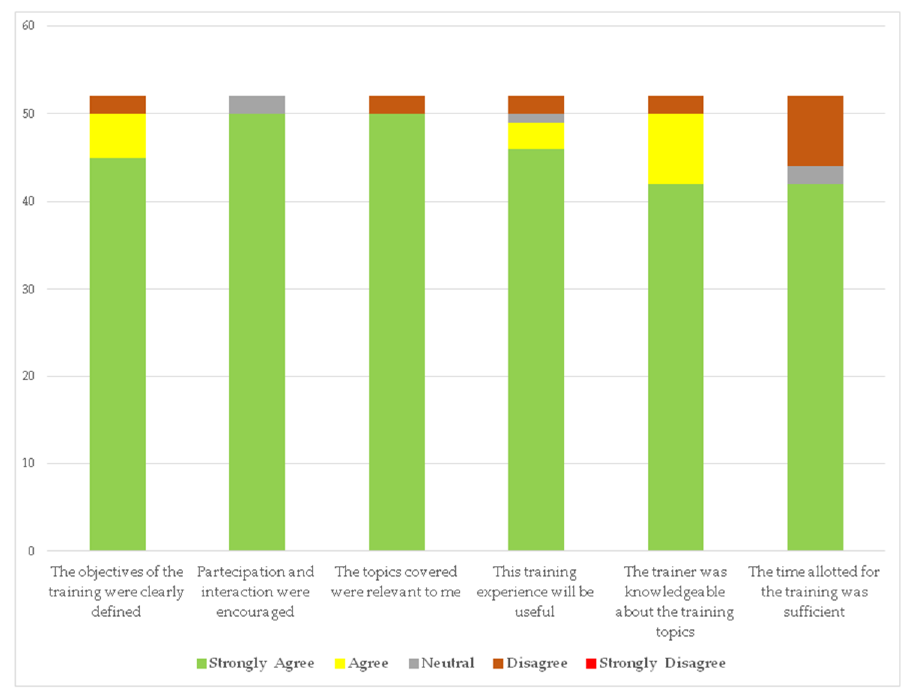
Figure 6. Satisfaction questionnaire results.